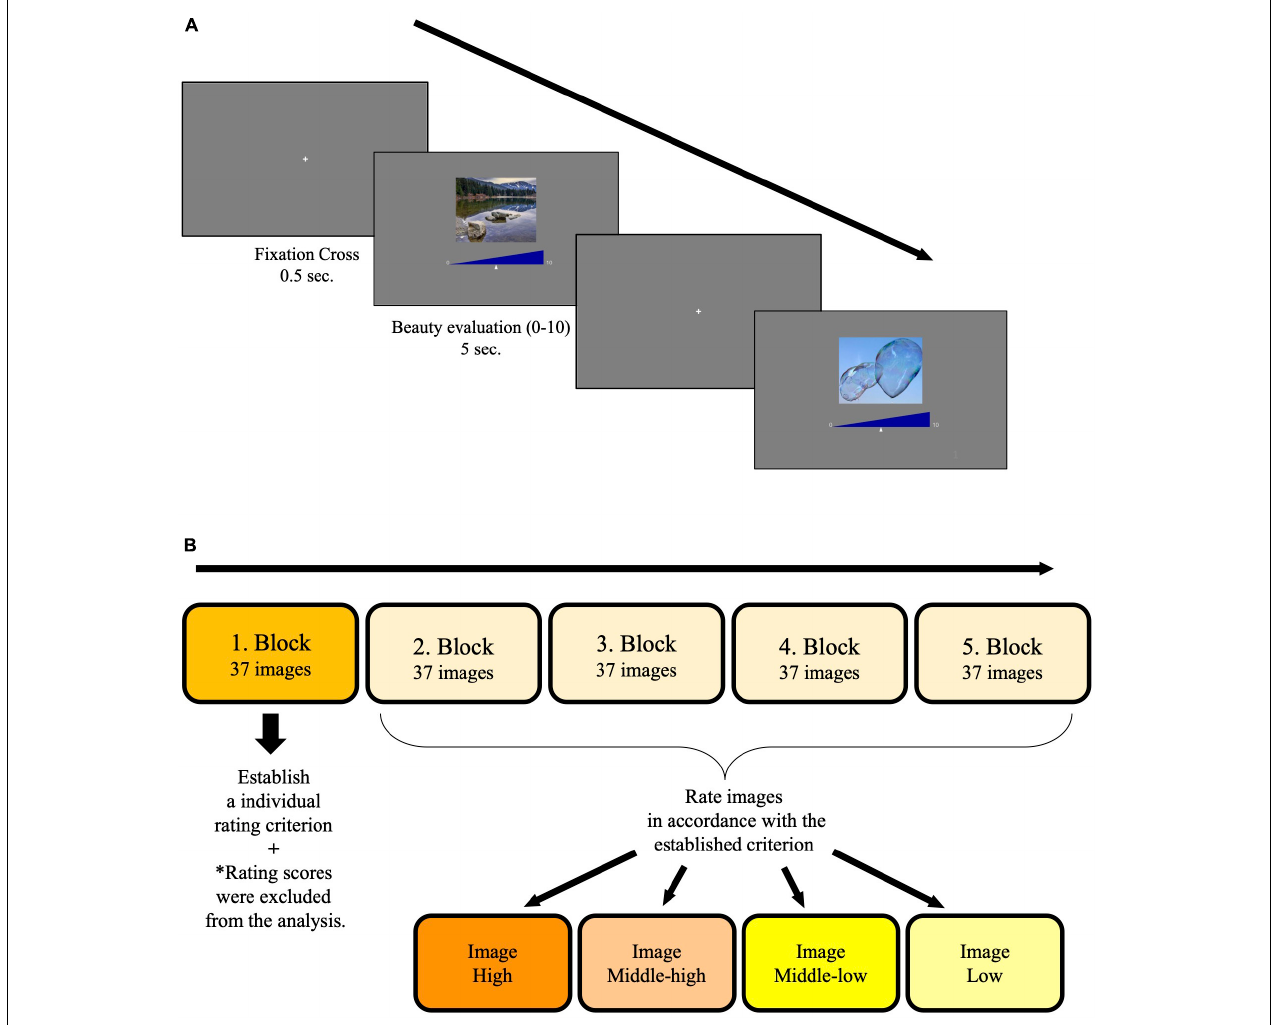
FIGURE 1 | (A) Design of trials in the blocks. In each trial, participants had to rate the level of beauty they perceived from an image by moving a small triangle along the scale. The left end of the scale corresponded to 0 (not beautiful at all), and the right end of the scale corresponded to 10 (absolutely beautiful). (B) Experimental design. Participants were told to establish an individual rating criterion in the first block. Images in the following blocks were rated in accordance with the established criterion and divided into four